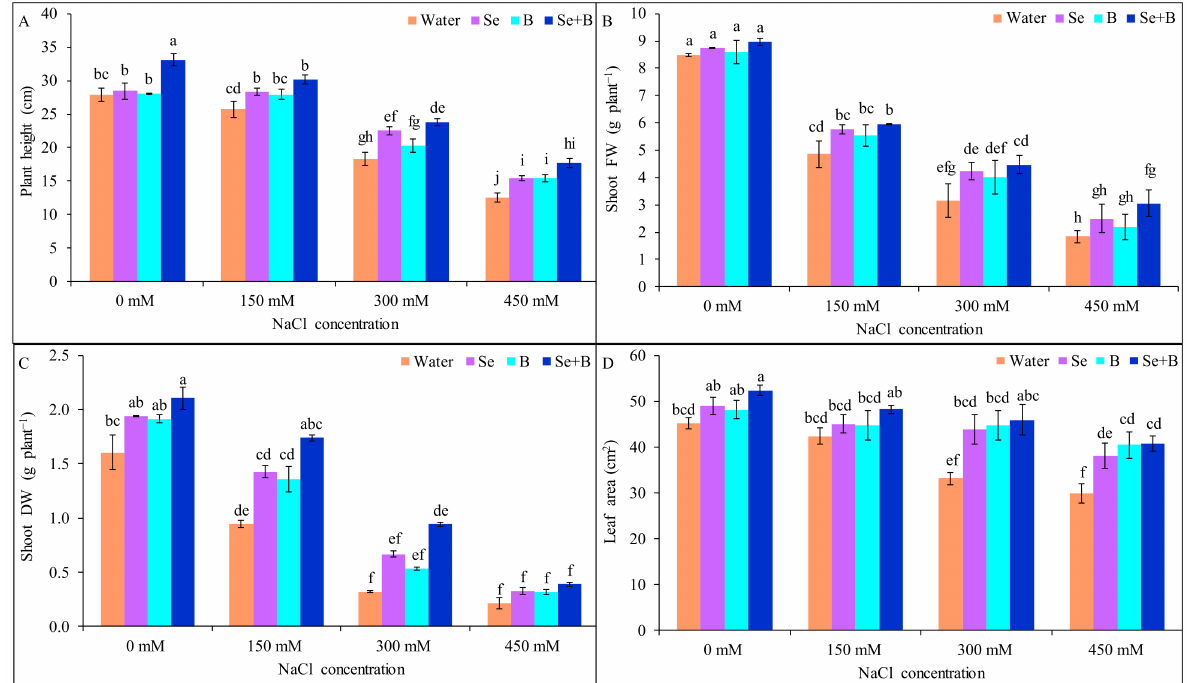
Figure 1. Effect of exogenous Se, B and Se+B on plant height ( A ), shoot FW ( B ), shoot DW ( C ) and leaf area ( D ) in soybean at 0, 150, 300 and 450 mM NaCl-induced salt stress. Here, Se, B and Se+B indicate 50 µ M Na 2 SeO 4 , 1 mM H 3 BO 3 and 50 µ M Na 2 SeO 4 + 1 mM H 3 BO 3 , respectively. Values in a column with different letters are significantly different at p ≤ 0.05 applying Fisher’s LSD